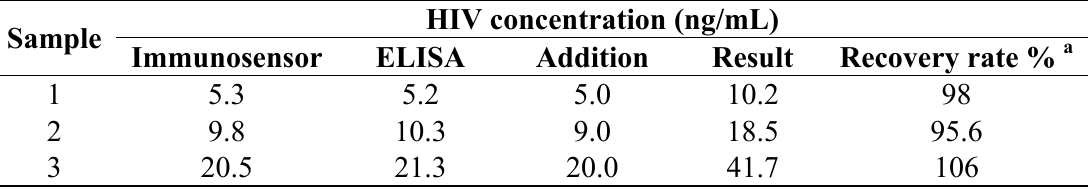
Table 1. Results of p24 determinations in human